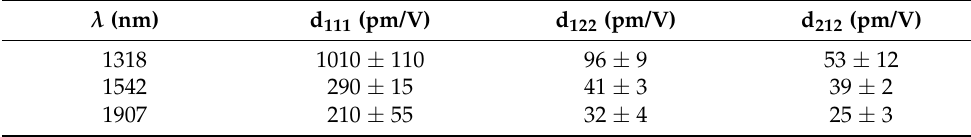
Table 8. NLO coefficients of DAST